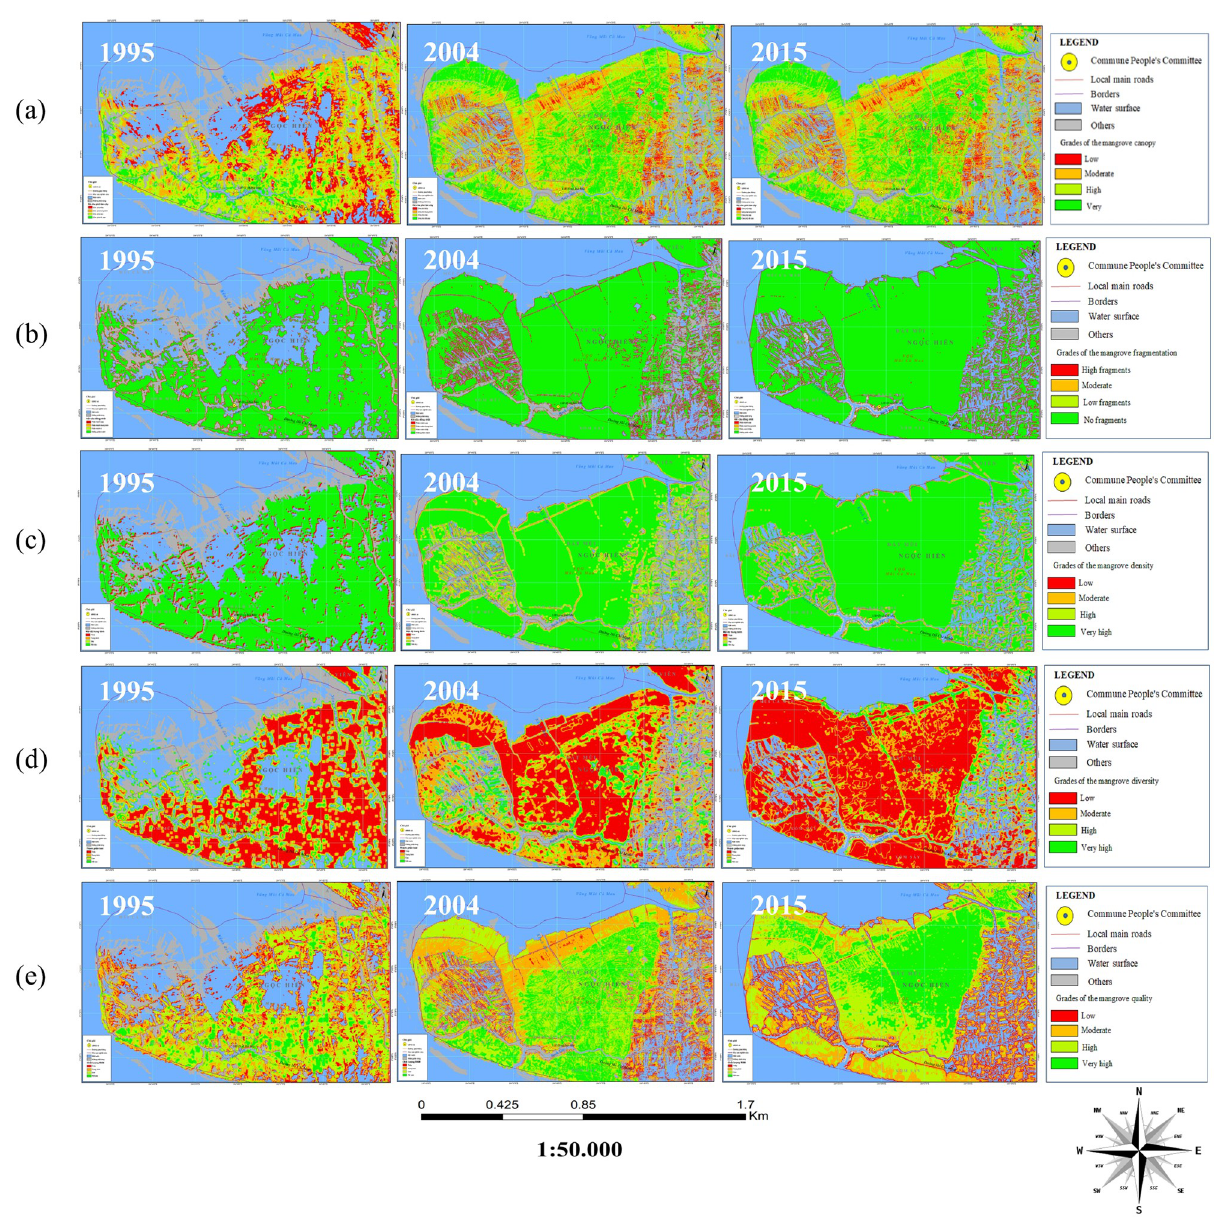
Fig 12. Mapping factors influencing mangrove health in Ca Mau: (a). The Mangrove canopy width map; (b). The Mangrove fragmentation map; (c). The Mangrove density map; (d) The Mangrove diversity map; (e). and The Mangrove health map. (Republished satellite data under a CC BY license, with permission from the Department of Remote Sensing, Ministry of Natural Resources and Environment of Vietnam, original copyright [1995, 2004, 2015]).